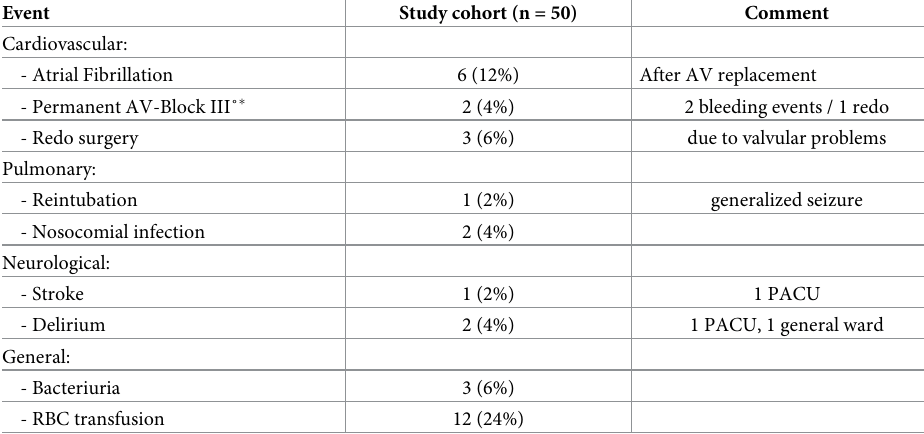
Table 4. Postoperative complications. � requiring pacemaker implantation.